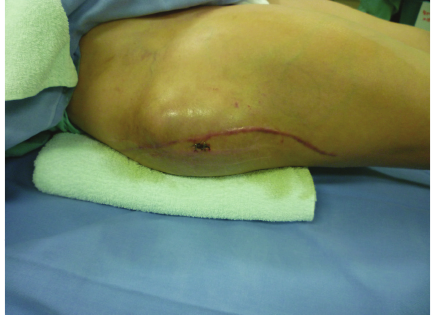
Figure 6: At day 3 after complete removal of the hematoma, the hematoma enlarged gradually and the thigh pain